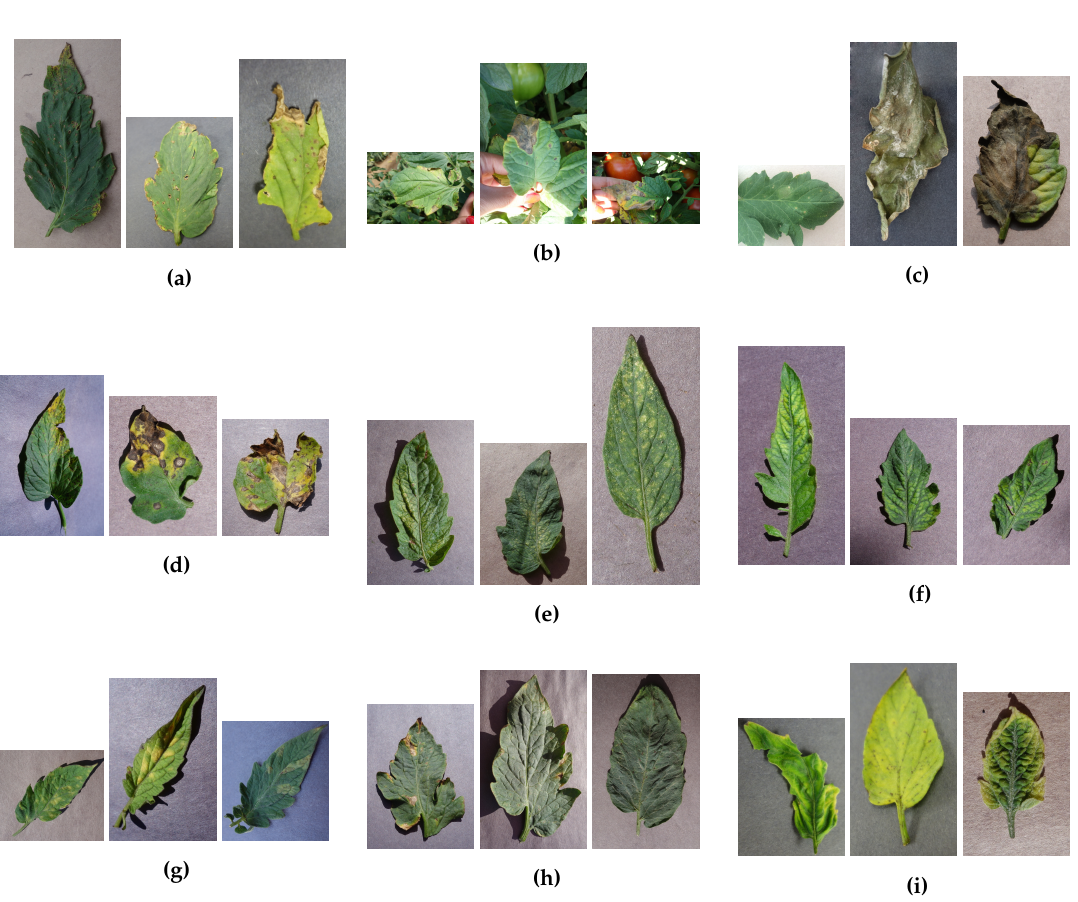
Figure A1. Images of examples of tomato diseases in the Plant Village dataset. ( a ) Xanthomonas campestris pv. Vesicatoria; ( b ) Alternaria solani ; ( c ) Phytophthora infestans ; ( d ) Septoria lycopersici ; ( e ) Tetranychus urticae ; ( f ) Tomato mosaic virus ; ( g ) Fulvia fulva ; ( h ) Corynespora cassiicola ; ( i ) T omato yellow leaf curl virus